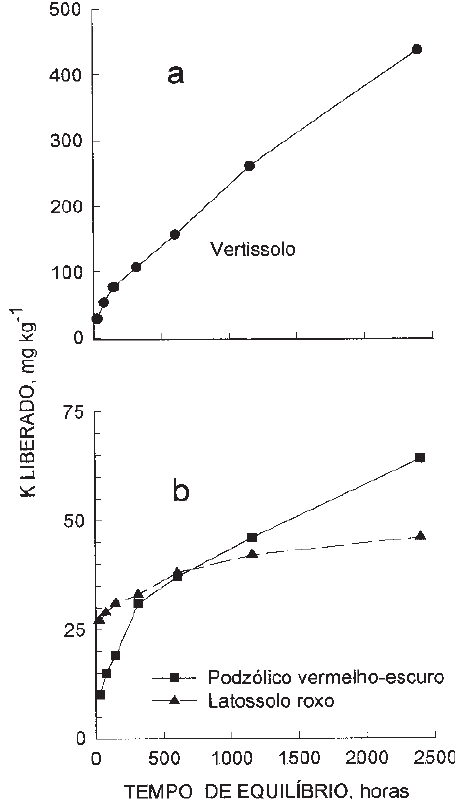
Figura 2. Liberação cumulativa de K não-trocável em função do tempo de equilíbrio (a) no vertissolo e (b) no podzólico vermelho-escuro e no latossolo